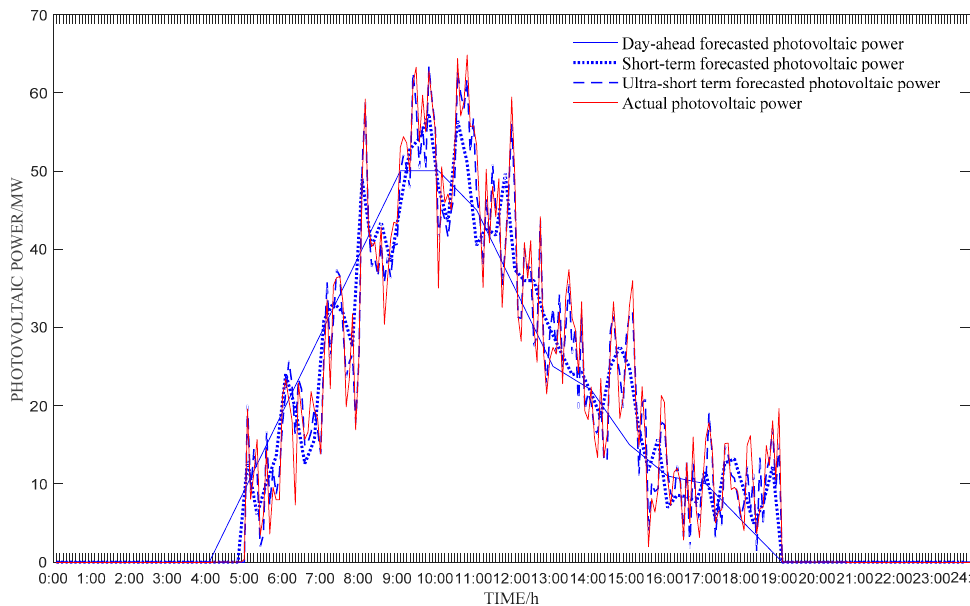
( c ) Actual and forecasted photovoltaic power in multi-time scales at node 7. Figure 3. Actual and forecasted wind–photovoltaic power load demand in multi-time scales.